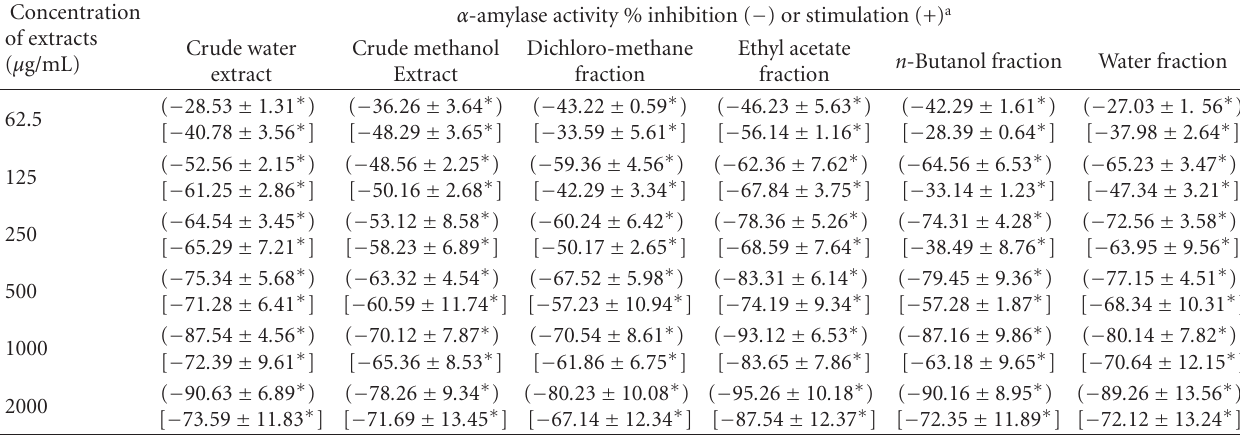
Table 1: E ff ects of AM and FF on α -amylase activity.